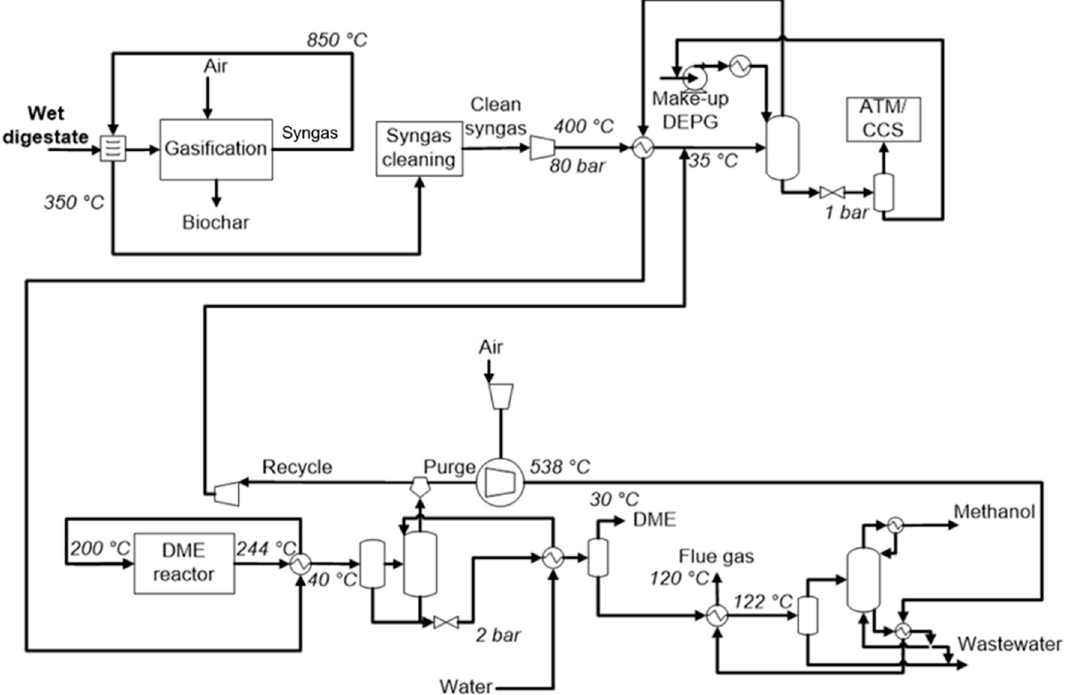
Figure 12. Flowsheet diagram for the optimal process result.